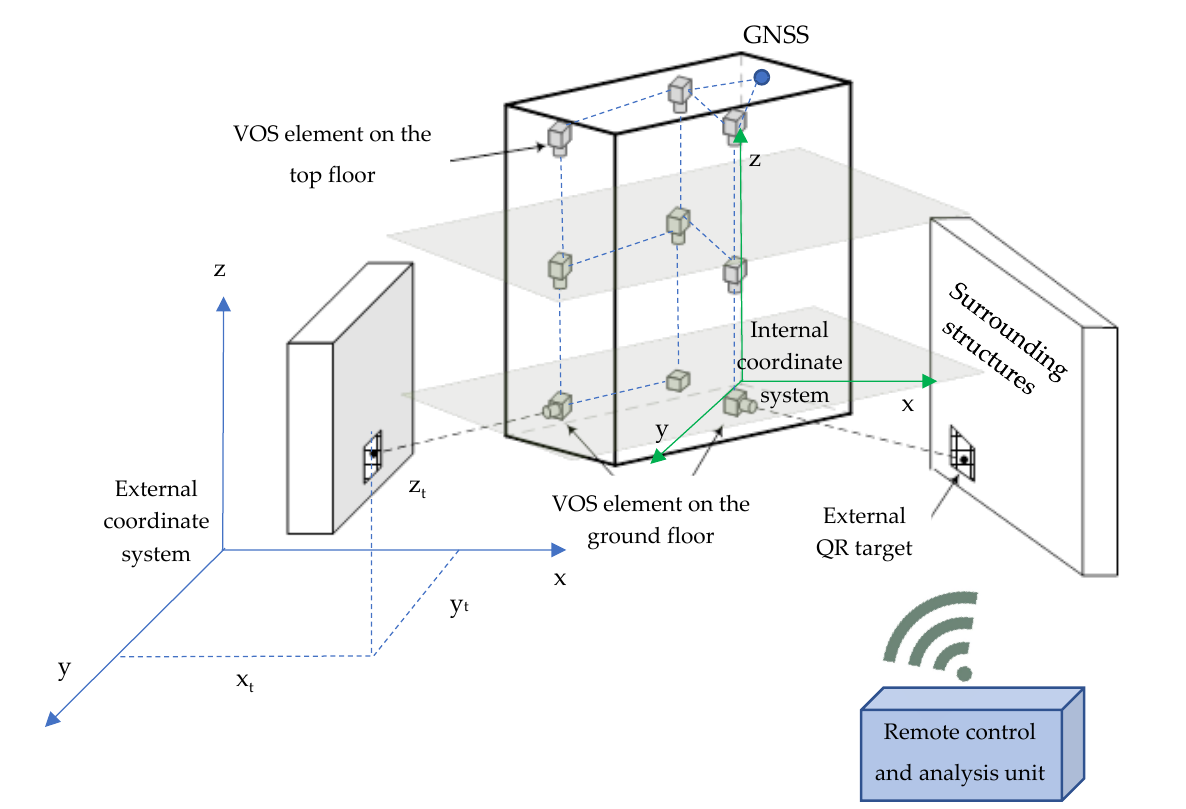
Figure 3. The general concept of the VOS and its installation.